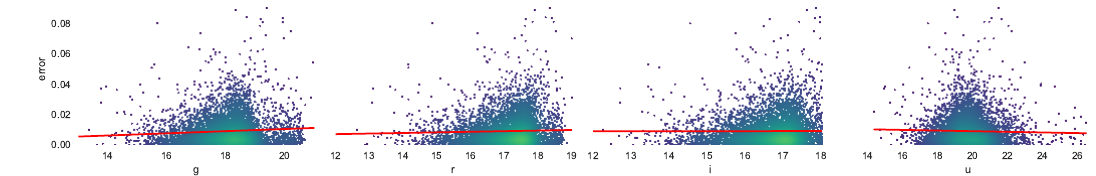
Figure 4. Absolute error when using the random forest classifier and different magnitude ranges. The red lines show the least square error linear regression.